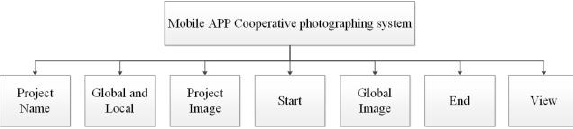
Figure 1. Function Design